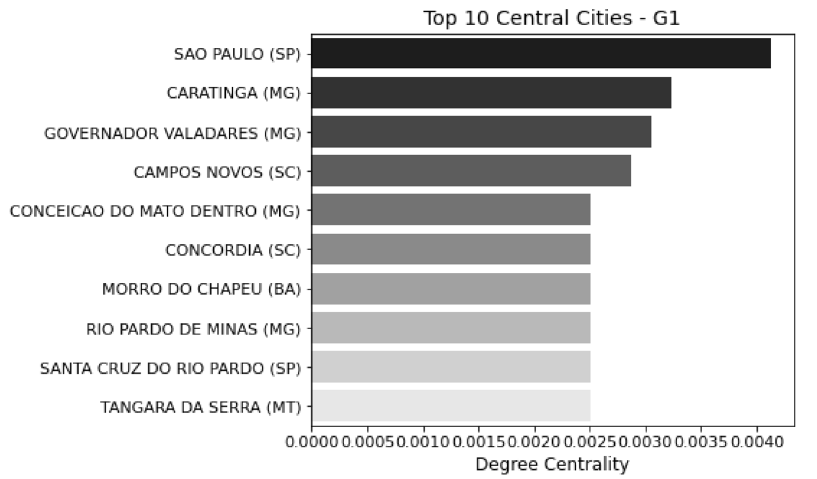
Figure 4. Top 10 central cities for G1.